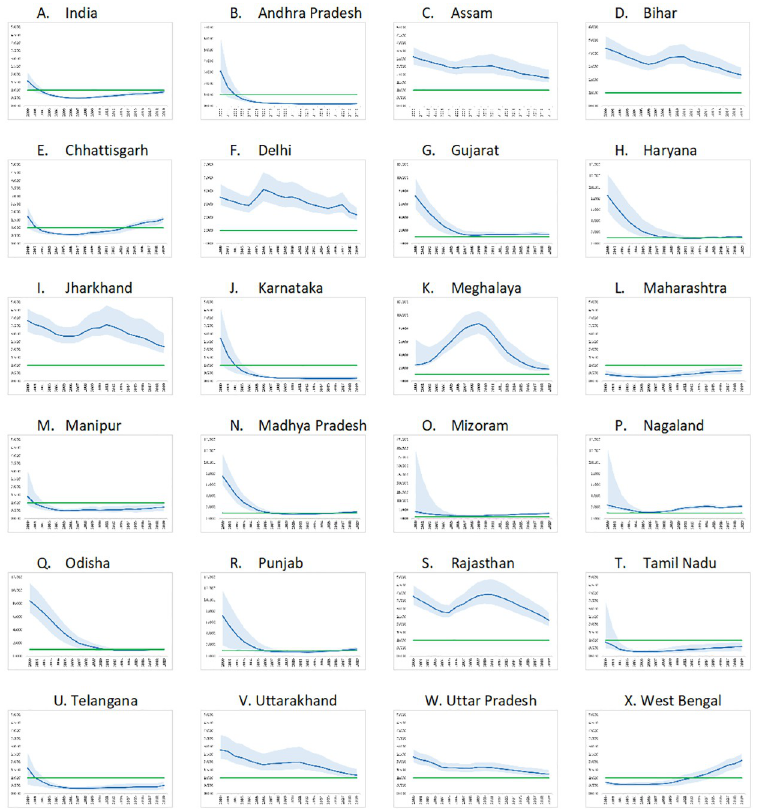
Fig 3. Incidence-mortality ratio by States in India, 2000–2019. The years (2000–2019) are reflected on X-axis while IMR is on Y-axis. The highest bound on Y-axis is 5.000 for all except for Andhra Pradesh (7.000), Bihar (6.000), Delhi (6.000), Gujarat (12.000), Haryana (14.000), Meghalaya (12.000), Madhya Pradesh (14.000), Mizoram (45.000), Nagaland (14.000), Odisha (12.000) and Punjab (14.000). Green line depicts target value of IMR for epidemic control, blue line represents point estimate and light blue shaded areas represents the uncertainty bounds for IMR of India/ State for the period 2000–2019.